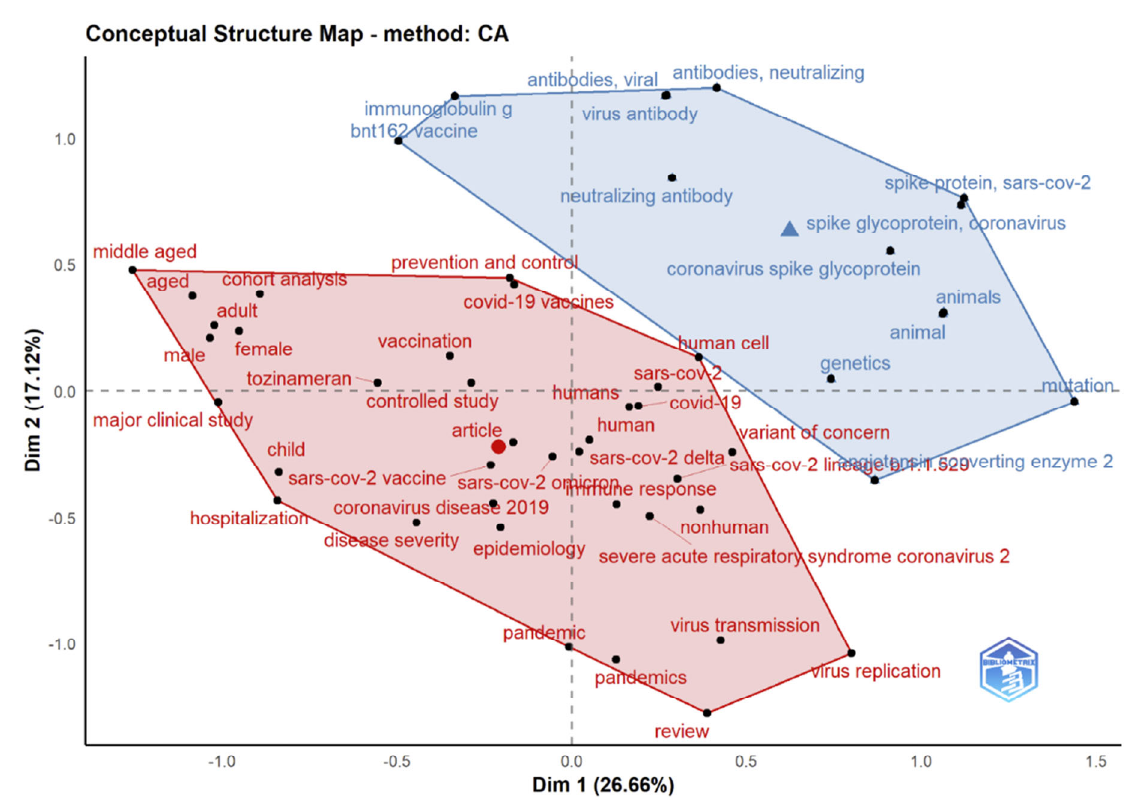
Figure 20. Conceptual structure map using correspondence analysis that integrates and correlates the knowledge of current studies on